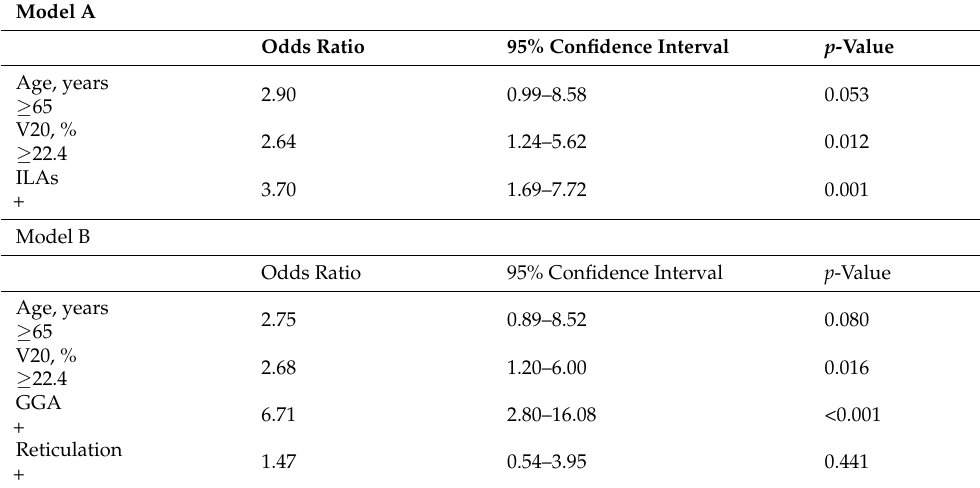
Table 5. Multivariate logistic regression analysis of risk factors for grade ≥ 2